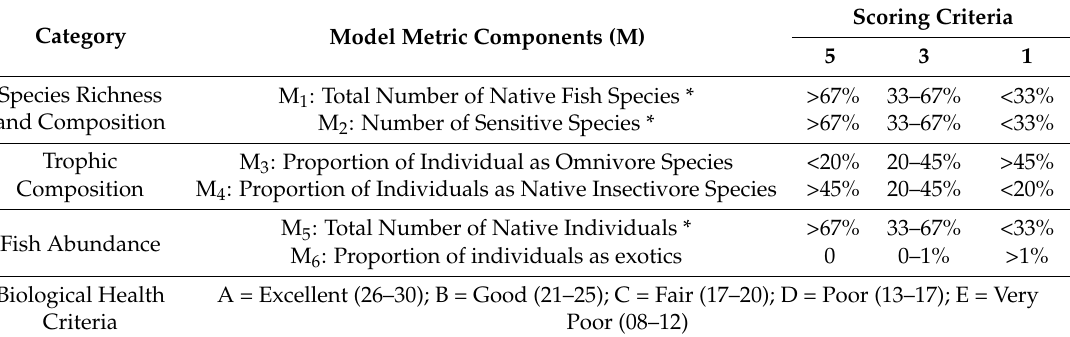
Table 3. Fish assemblages types, metrics and their ascribed scoring criteria in newer 06 metric IBI model (mmIBI 06